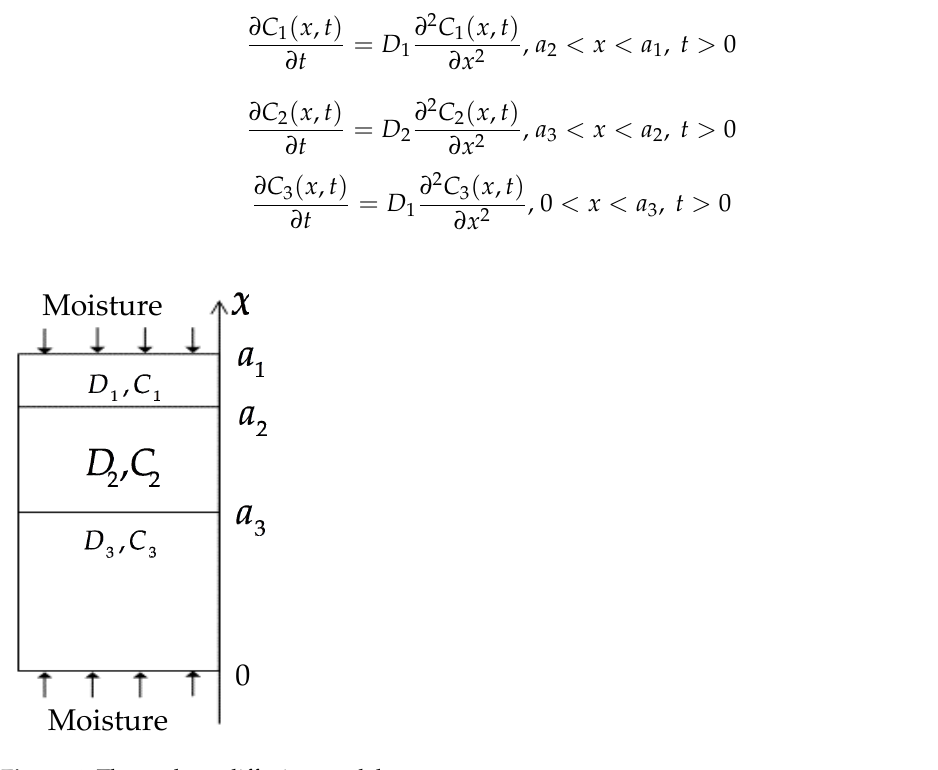
Figure 4. Three-phase diffusion model.